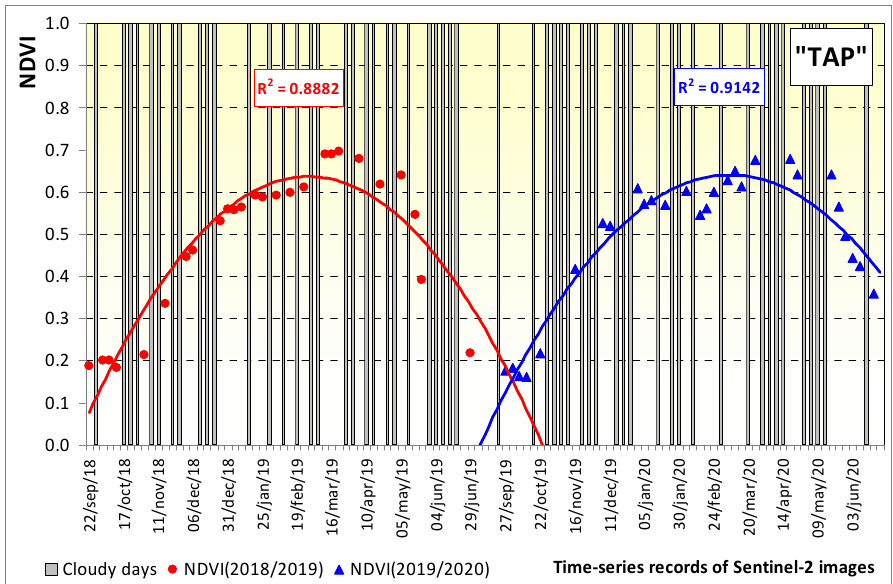
Figure 14. NDVI time-series records obtained in 2018/2019 and 2019/2020 in “TAP” field. The number of Sentinel-2 images of the six experimental fields during autumn, winter, and spring of 2018/2019 and 2019/2020 without cloud effect (cloudless days) amount to approximately only half (51.0 ± 6.2%) of the total number of satellite images available in the same period (Table 1). These cloudless days are distributed evenly over the three seasons under consideration (autumn, winter, and spring).